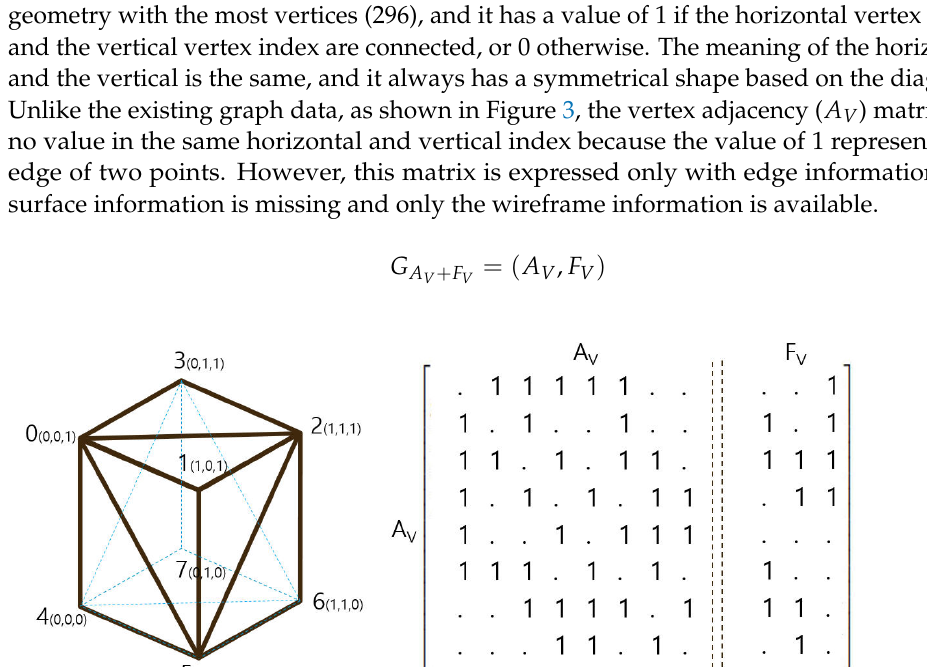
and face count. This will be explained again in Section 4.